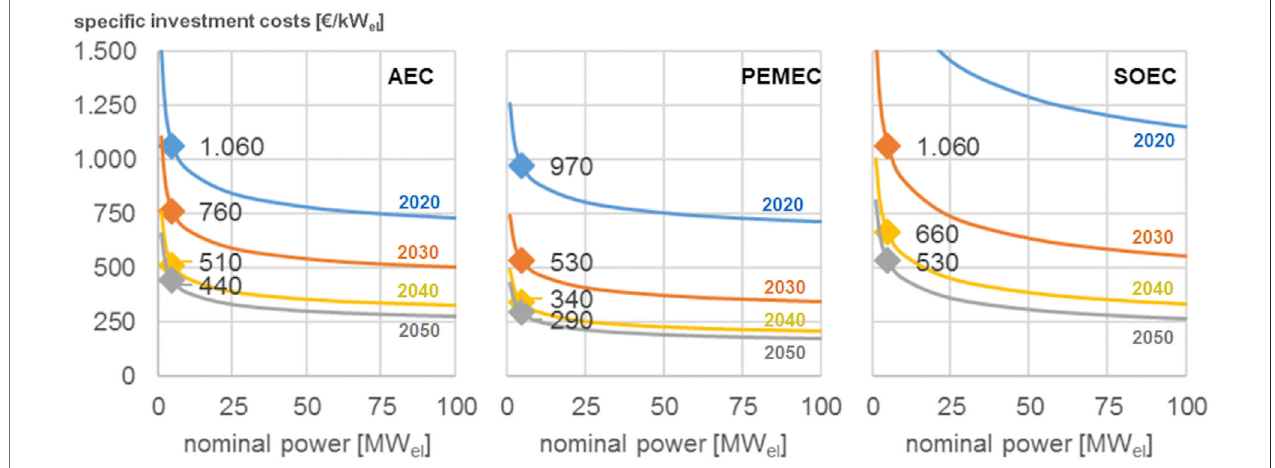
FIGURE 2 | Cost development of H 2 electrolyzers for three type of electrolyzers (PEMEC, Proton Exchange Membrane Electrolyzer; AEC, Alkaline Electrolyzer; SOEC, Solid Oxide) as function of the nominal power of the electrolyzers and estimated decrease in costs of production for different years in the 2020 – 2050 range. Elaborated from Zauner et al. (2019). No